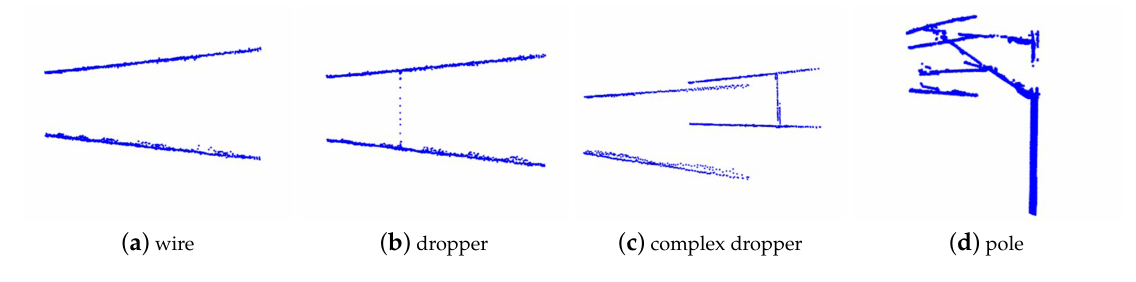
Figure 8. Categories of multi frame point